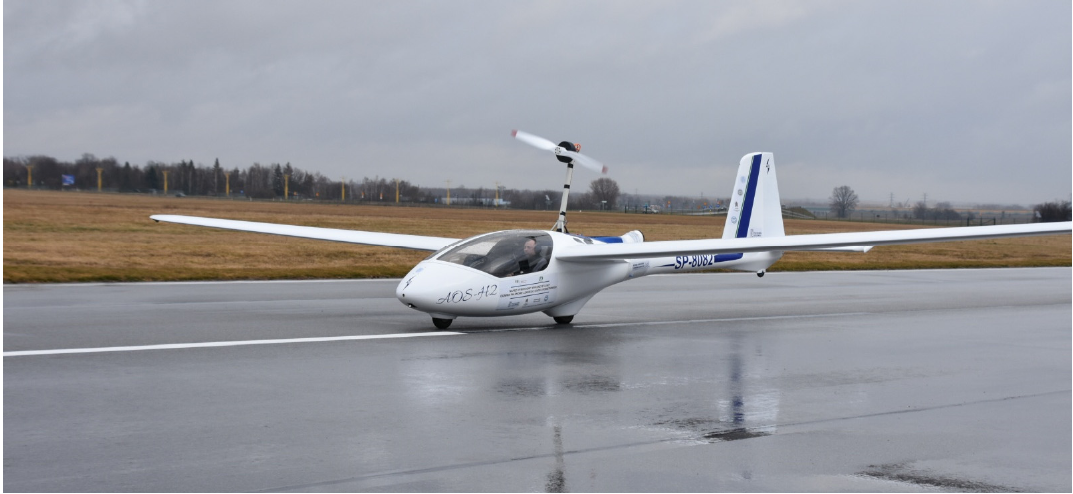
Figure 12. The AOS-H2 motor glider on the runway of the Aviation Training Centre of Rzeszow University of Technol- ogy.